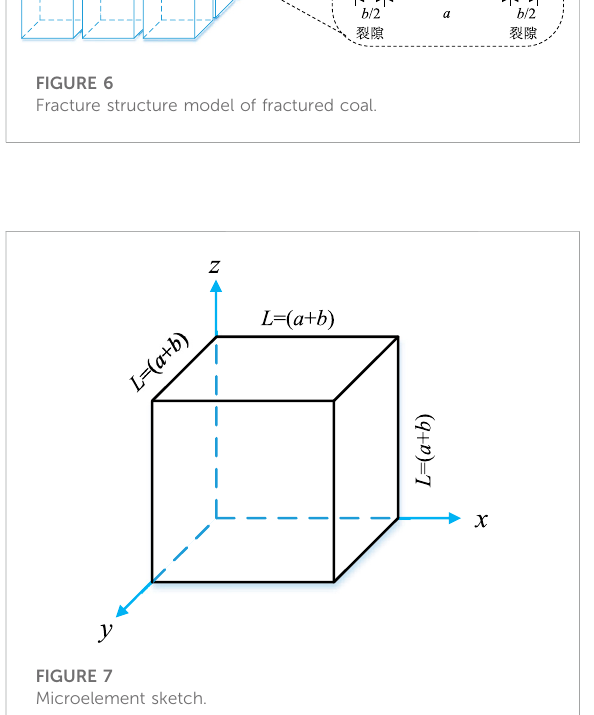
FIGURE 8 Rough single fracture